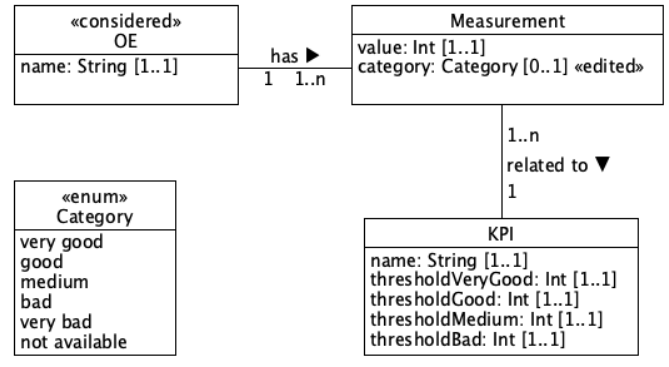
Figure 7. Metamodel described by the Syntax Building Block as part of the Analysis Technique The semantics of the syntax is described using a Rule-based Semantics Building Block that contains rules for translating measured values into categories of the category system. This is a special form of describing semantics (see [21]). An example of such a rule is “If the Measurement’s value is lower than thresholdBad , then set Measurement’s category to very bad